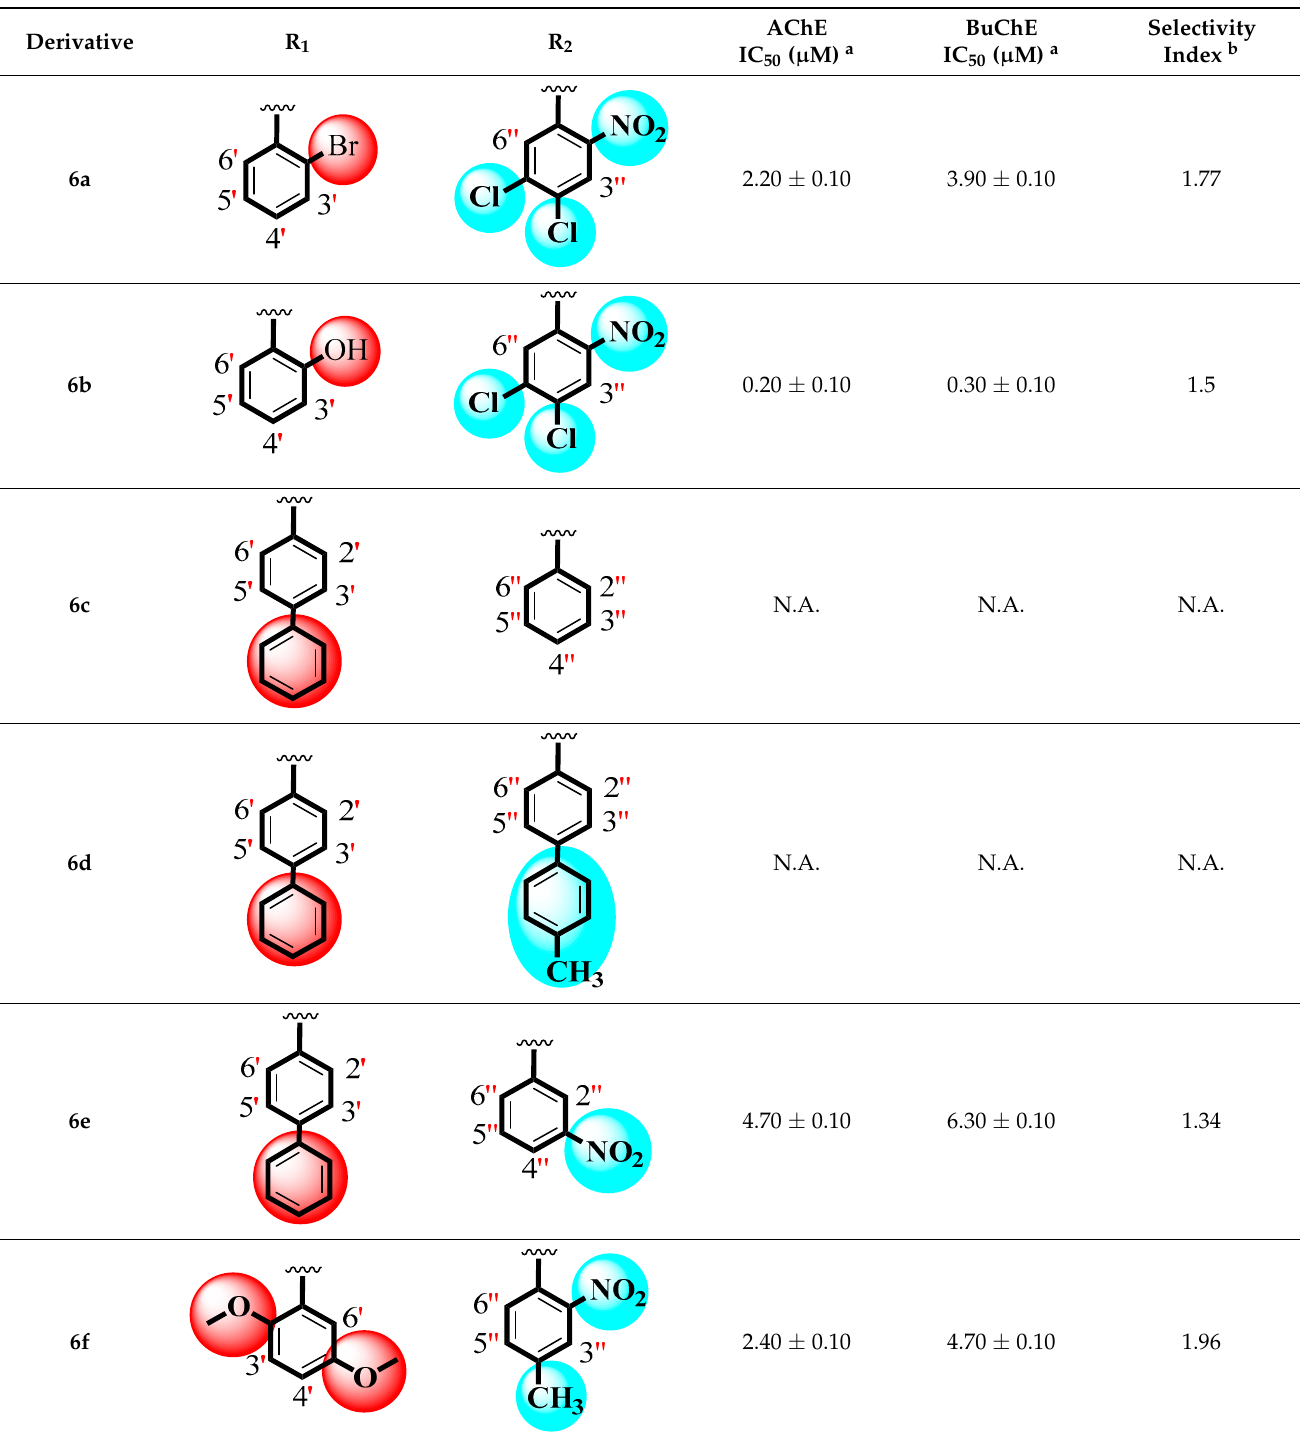
Table 1. Substituents, in vitro acetylcholinesterase and butyrylcholinesterase inhibitory activities, and selectivity index of triazole-based thiosemicarbazone derivatives ( 6a–u ).